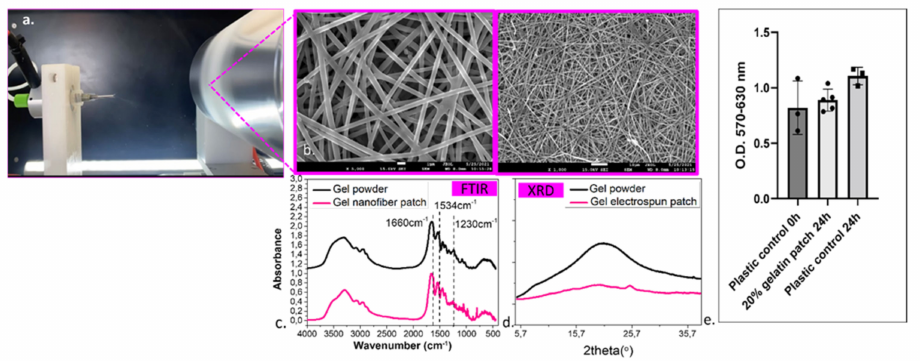
Figure 4. ( a ) Fabrication of gel patch with electrospinning process, characterization of gel patch, ( b ) SEM images, ( c ) FTIR spectra, ( d ) XRD patterns, and ( e ) MTT biocompatibility assay. The number of replicates per condition is indicated on the graph, statistical analysis mean ± SD, t-student